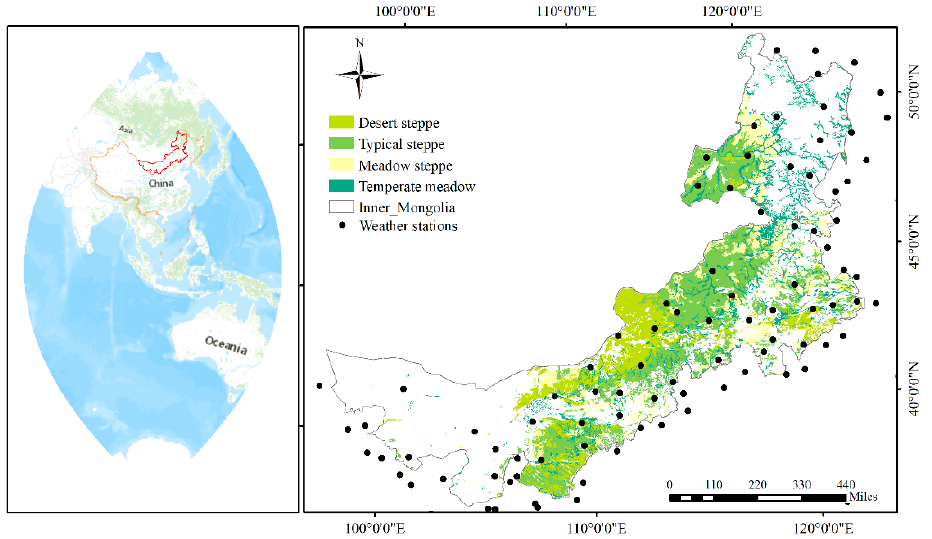
Figure 1. The grassland types in the study